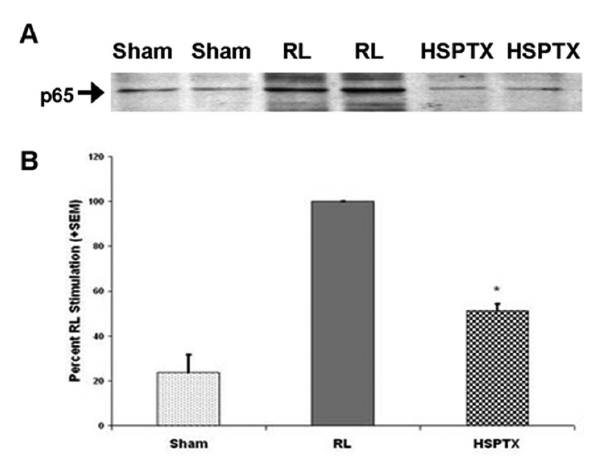
Figure 2 - Nuclear p65 NF- κ B Phosphorylation. A, Western blot of phos- phorylated p65 NF- κ B in pulmonary nuclear extracts after hemorrhagic shock and resuscitation. The image displays two representative animals from each experimental group. B, RL infusion markedly enhanced nuclear NF- κ B phos- phorylation. A 49% attenuation in nuclear p65 phosphorylation was seen when HSPTX was utilized for treatment after shock. The graph presents changes in the mean pixel density for n = 5-7 animals per group. *, p < 0.01 vs. RL